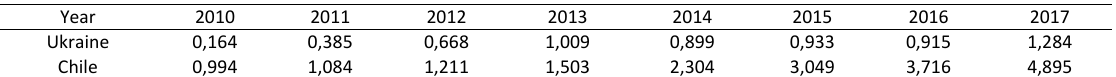
Table 1: Installed capacity in Ukraine and Chile 2010 vs 2017, GW